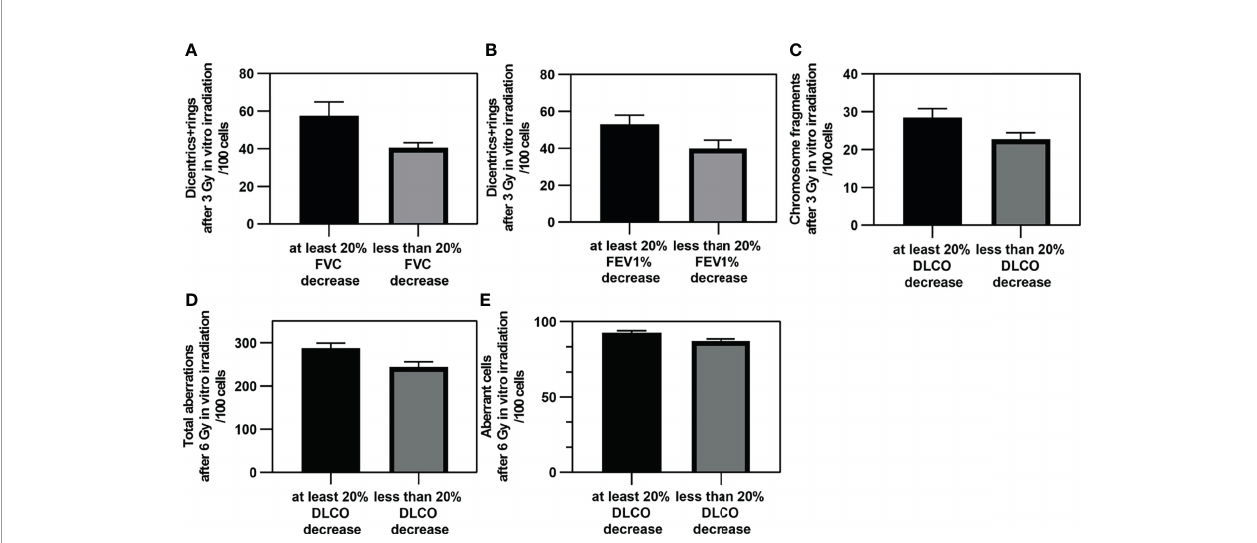
FIGURE 3 | The signi fi cant differences in chromosome aberrations between patients with severe and slight pulmonary function decrease. The mean (± SE) of in vitro chromosome aberrations of patients before radiotherapy who developed severe or slight/no pulmonary function decrease after radiotherapy of the lung. (A) Dicentrics plus rings after 3 Gy and FVC. (B) Dicentrics plus rings after 3 Gy and FEV1%. (C) Chromosome fragments after 3 Gy and DLCO. (D) Total aberrations after 6 Gy and DLCO. (E) Aberrant cells after 6 Gy and DLCO. The difference between the chromosomal aberration values are found to be signi fi cant with Mann-Whitney U test ( p < 0.05).